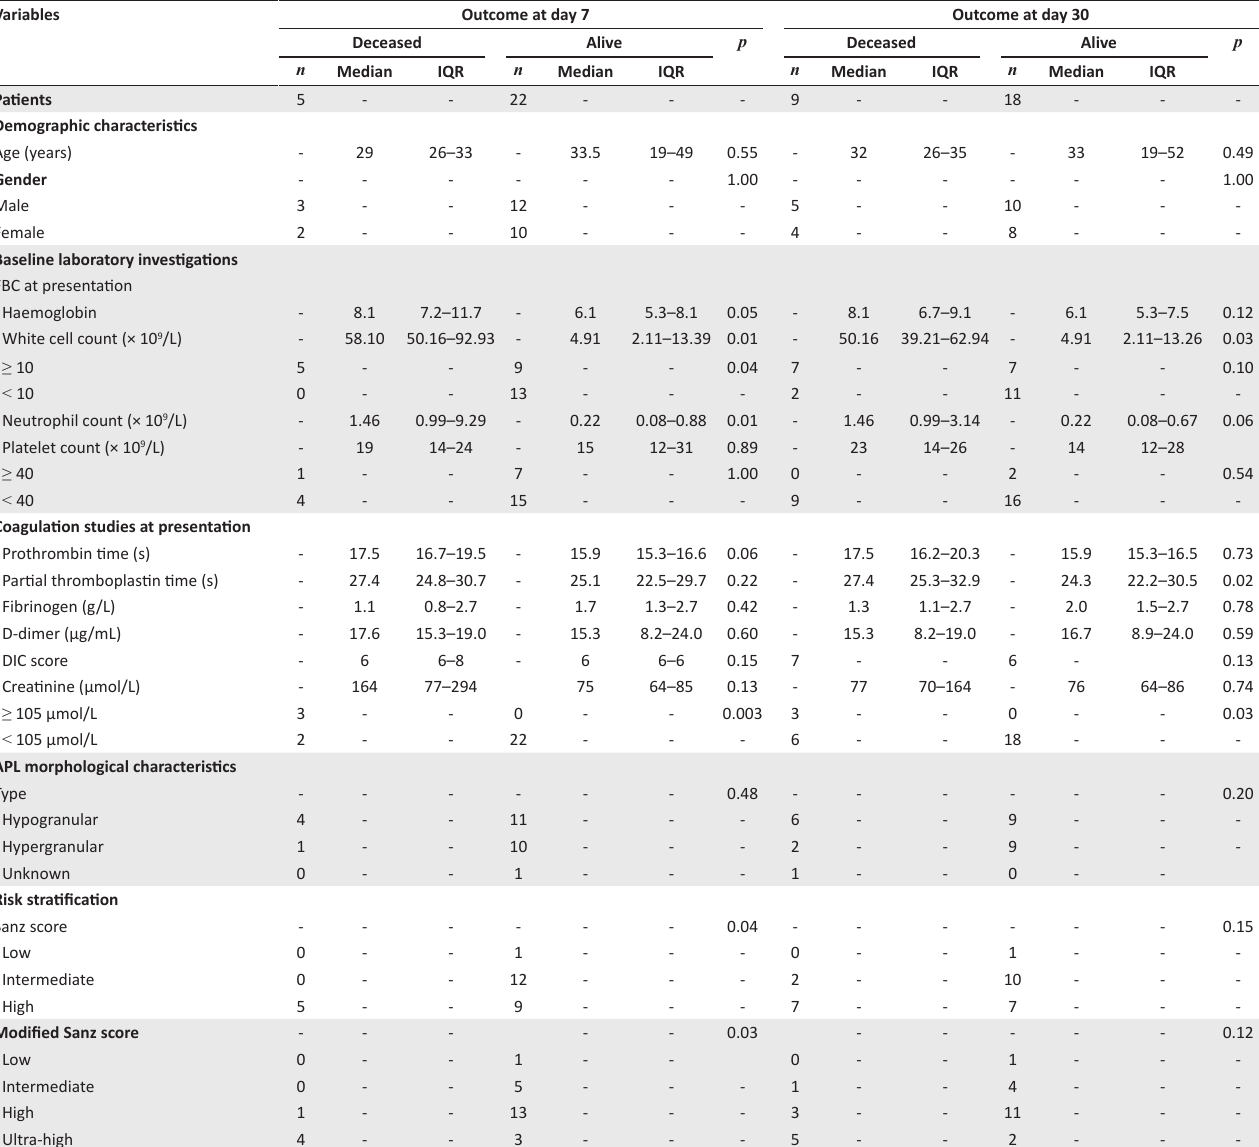
TABLE 6a: Comparison between the demographic and laboratory parameters with the short-term (7- and 30-day) outcome of patients with acute promyelocytic leukaemia. Variables